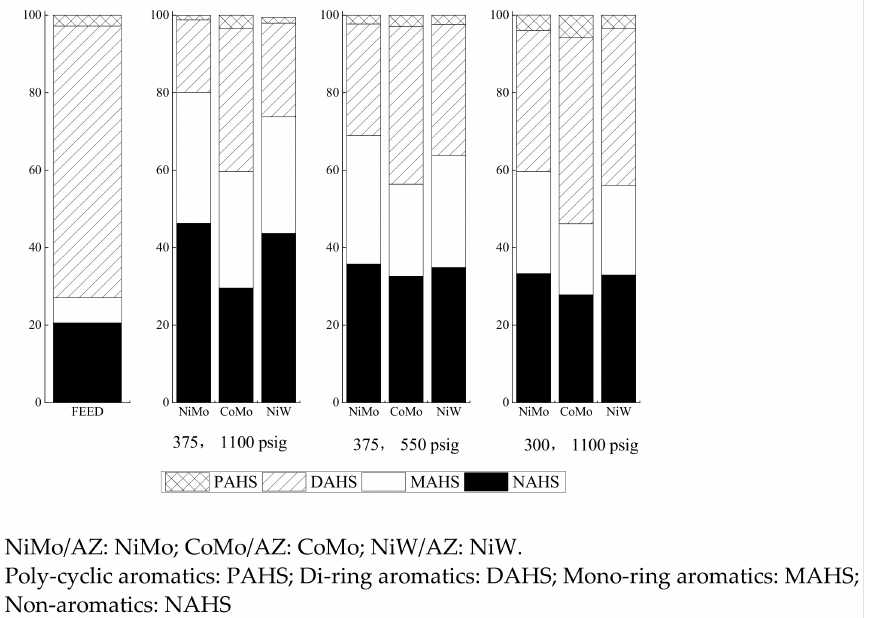
Figure 14. Hydrocarbon distributions in the final product with LCO2